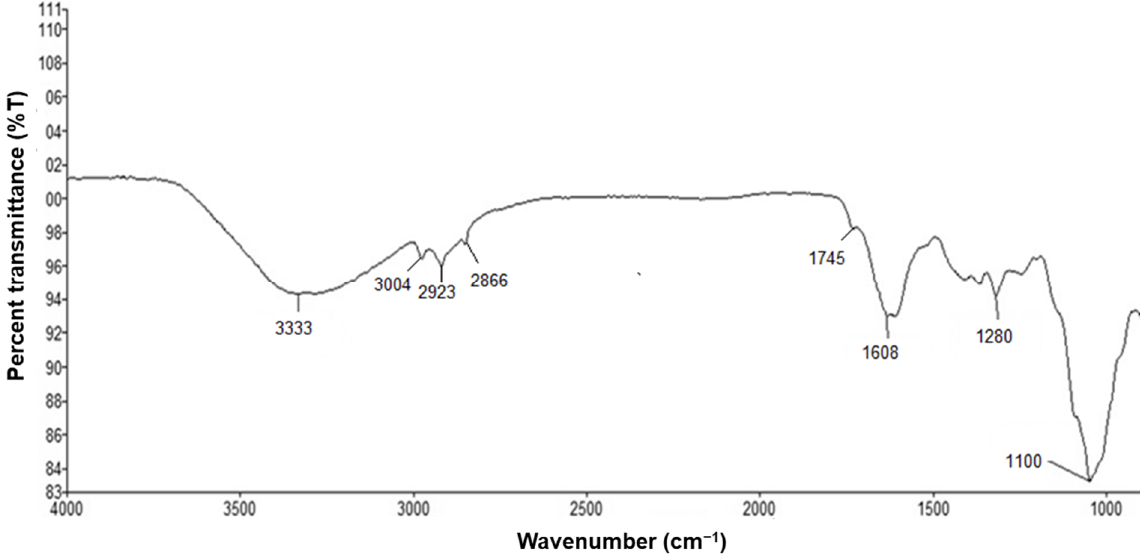
Figure 5. FT-IR spectra of green-synthesized CuNPs of star anise showing probable functional groups in synthesized nanoparticles.